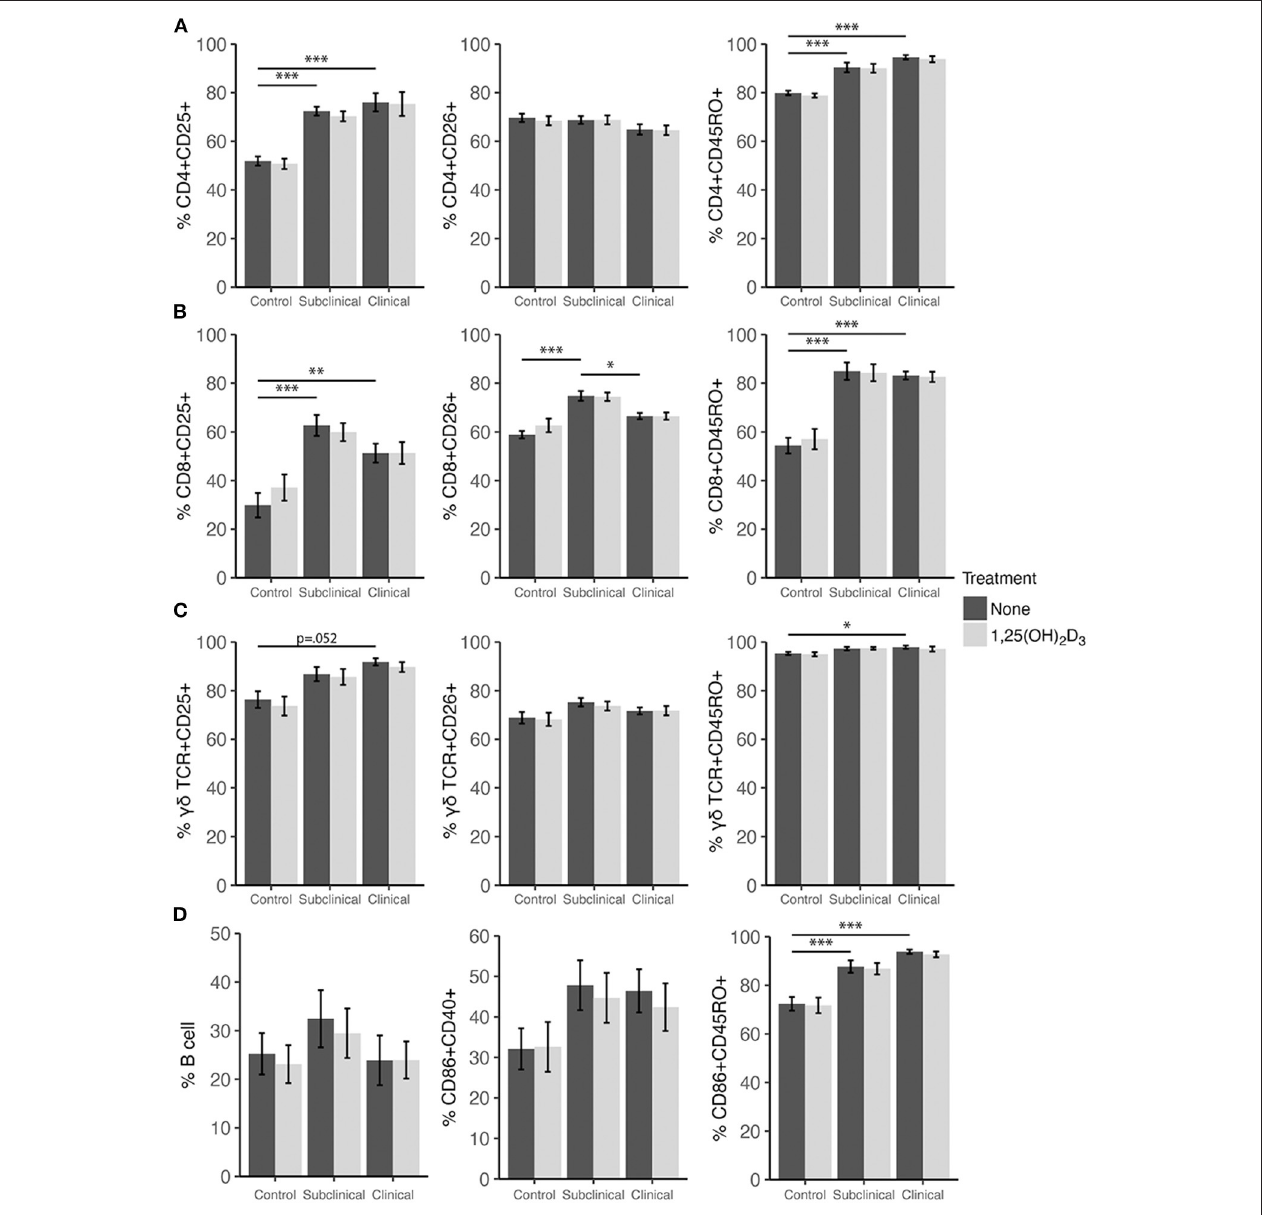
FIGURE 6 | Expression of activation and memory markers on the surface of (A) CD4 + , (B) CD8 + , (C) γδ T cells, (D) monocytes, and total B cells. Peripheral blood mononuclear cells were isolated from naturally infected dairy cattle (subclinical n = 8, clinical n = 8) or non-infected controls ( n = 8) and cultured 144h with whole cell MAP sonicate (MPS) ± 4ng/ml 1,25(OH) 2 D 3 . Surface markers were detected using fluorescently labeled antibodies and a flow cytometer. Data are presented as the mean percentage ± SE and significance levels are as follows: * < 0.05, ** < 0.01, *** < 0.001.